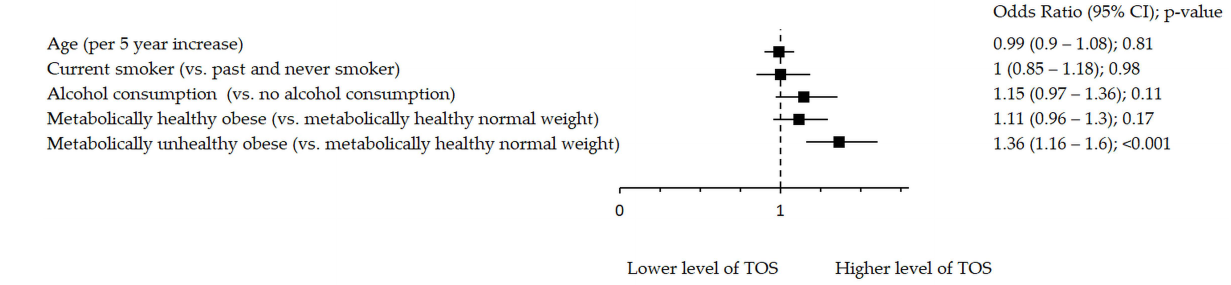
Figure 3. Association between TOS and metabolic health status. The forest plot shows multivariable analyses. The odds ratio with 95% confidence interval (CI) was obtained for precision and adjusted by age, smoking and